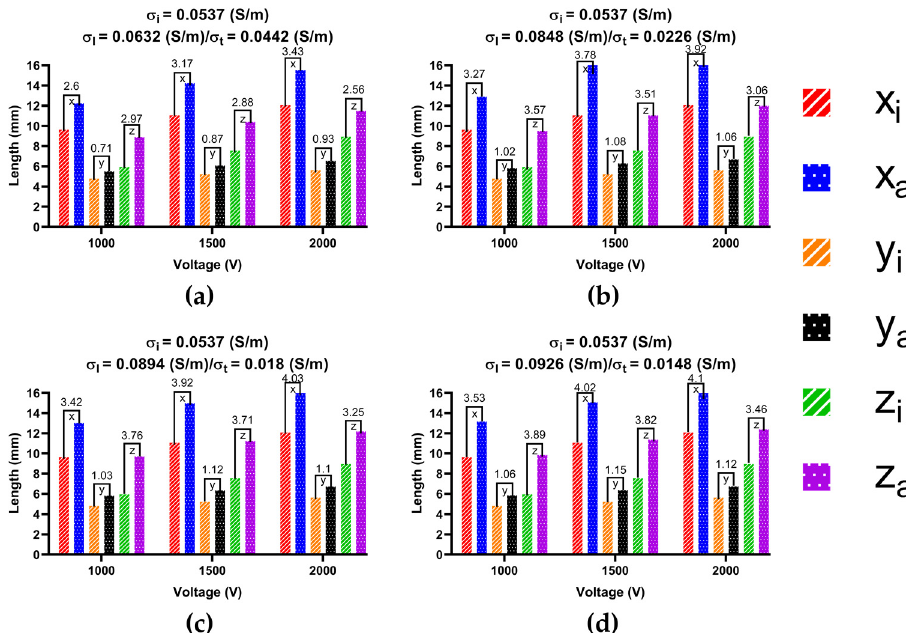
Figure 14. The statistical results of the size of the ablation isosurface under the condition of different PFA amplitudes at ablation target 3. The statistical results of the size of the ablation isosurface in myocardial electrical conductivity ( a ) group 1; ( b ) group 2; ( c ) group 3; and ( d ) group 4.